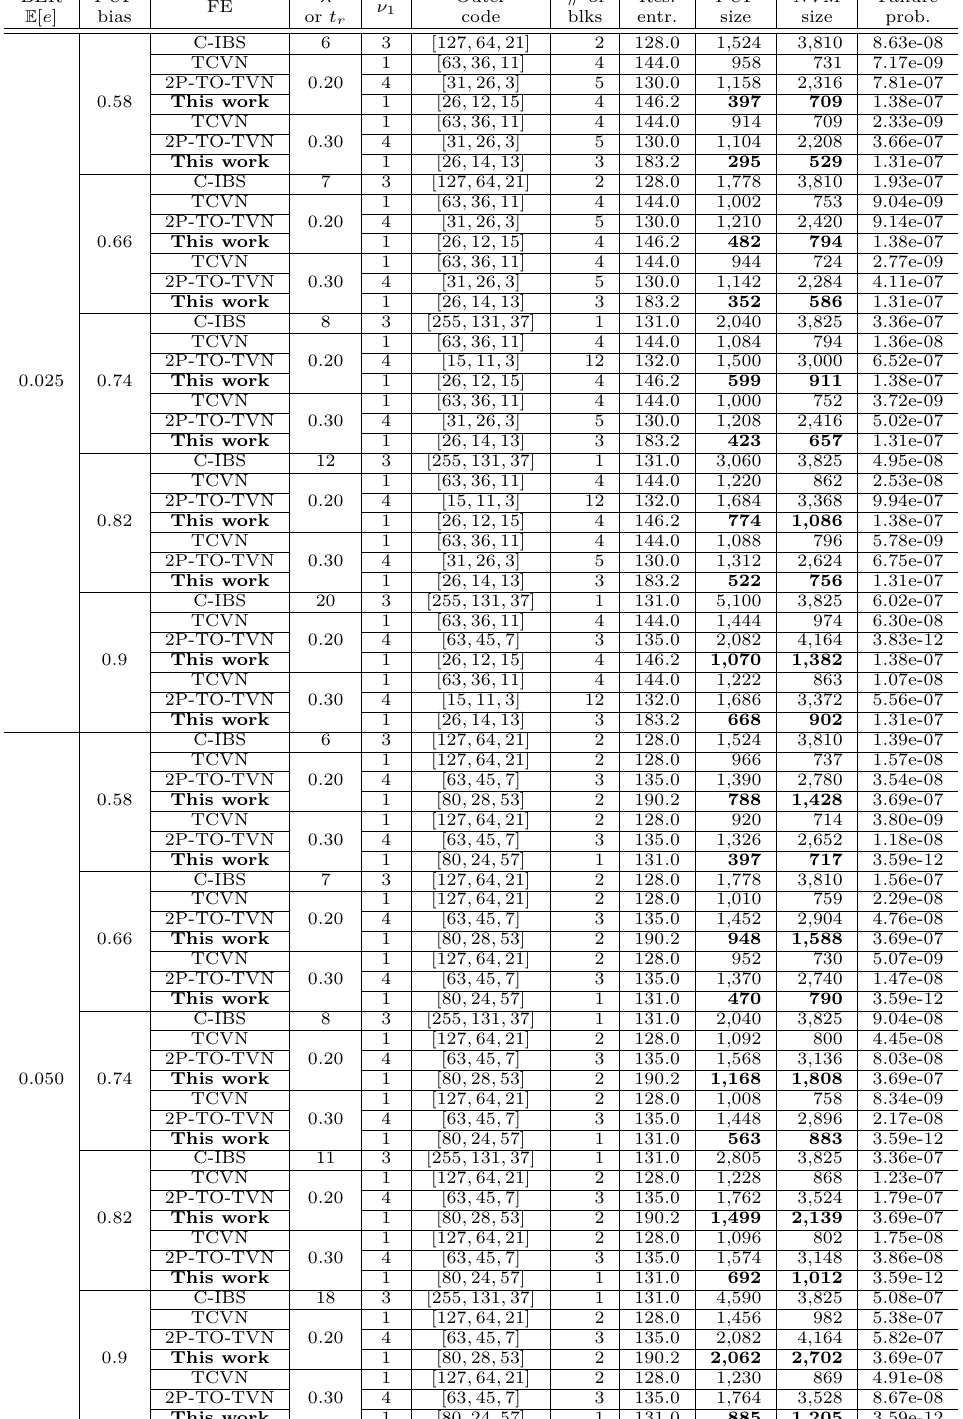
Table 7: Simulation results of 128-bit key generation using C-IBS and ternary debiasing- based FEs for averaged BER E [ e ] = 0 . 025 and 0 .